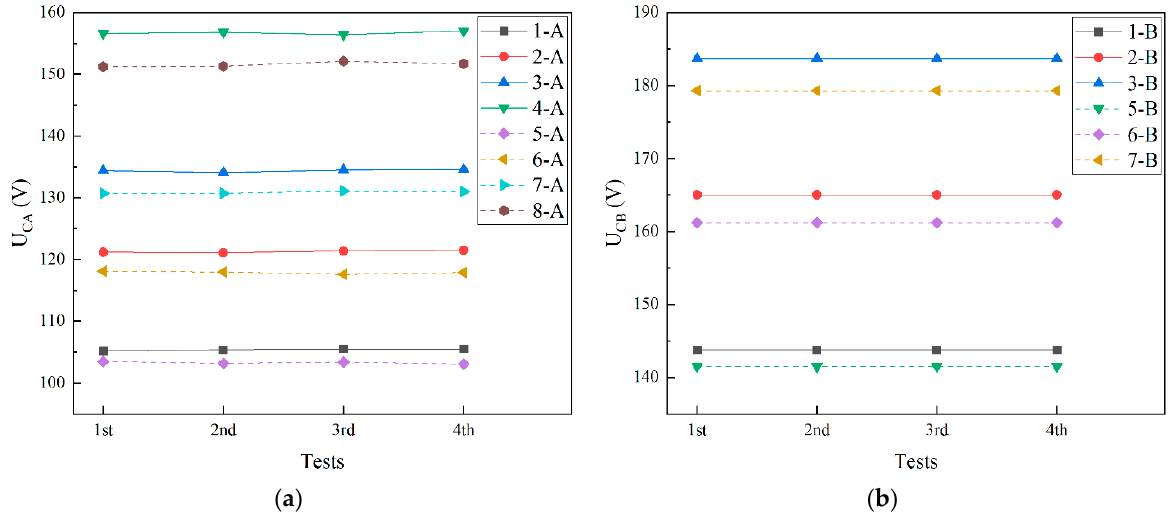
Figure 9. Measure results of test structures: ( a ) test structure A; ( b ) test structure B. Table 5. Experimental results of test structures.